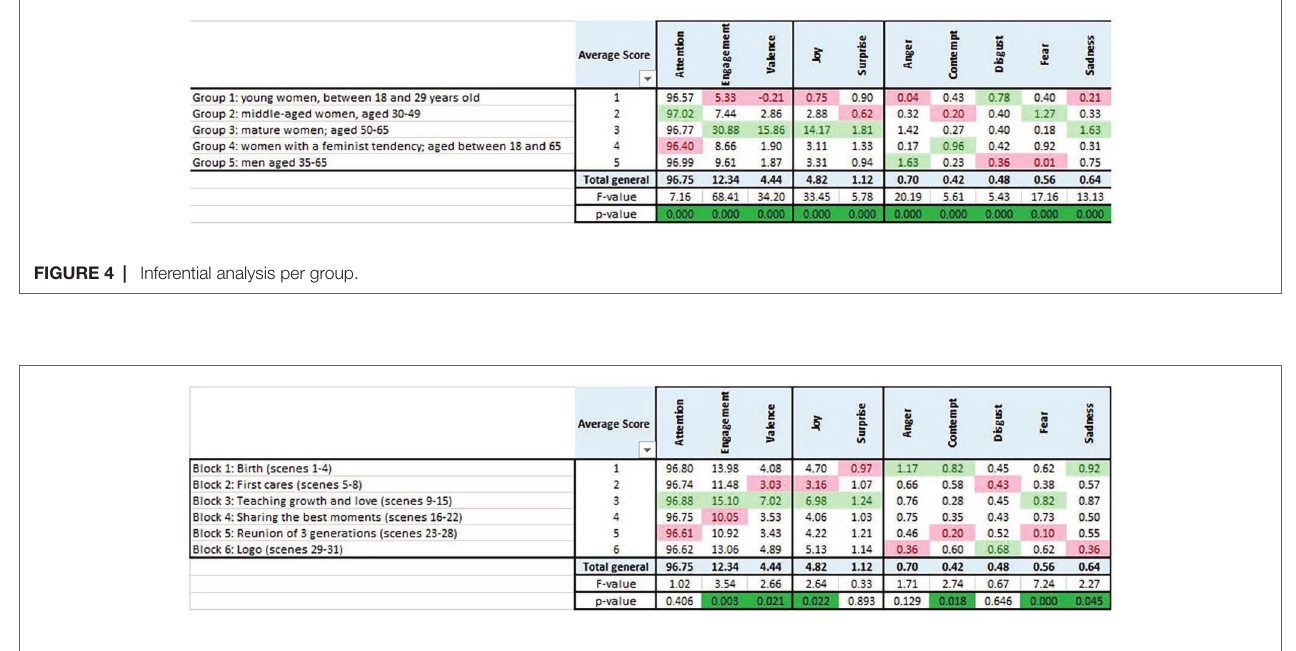
FIGURE 5 | Inferential analysis per